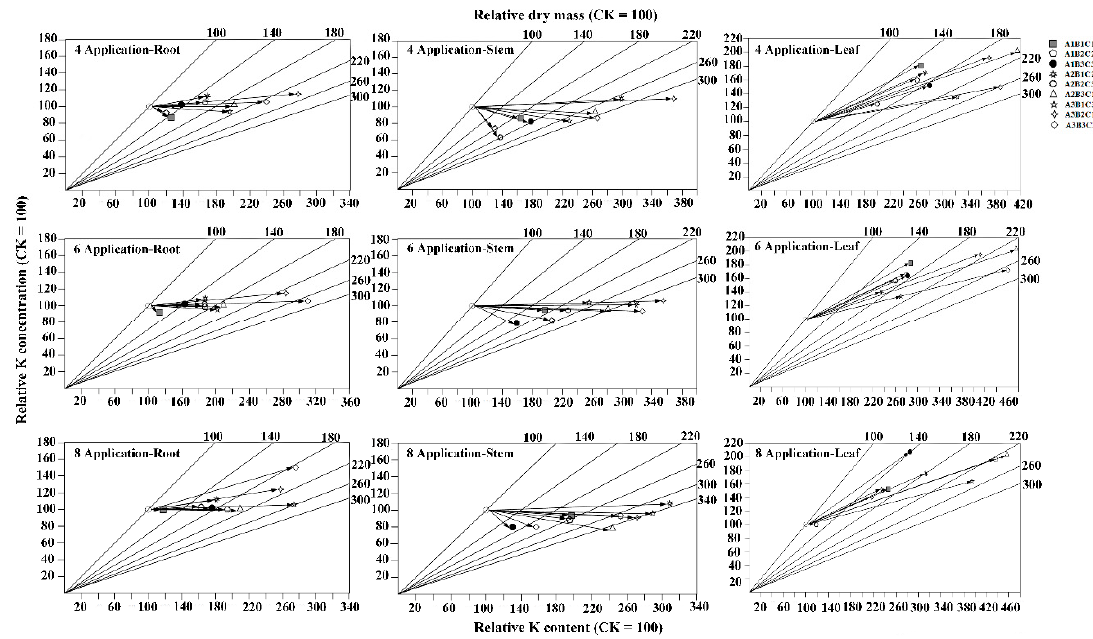
Figure 8. Vector diagram of relative changes in dry mass, K content, and K concentration at the end of the growing season after application of NPK fertilizer. Note that this vector diagram is based on the status of CK.